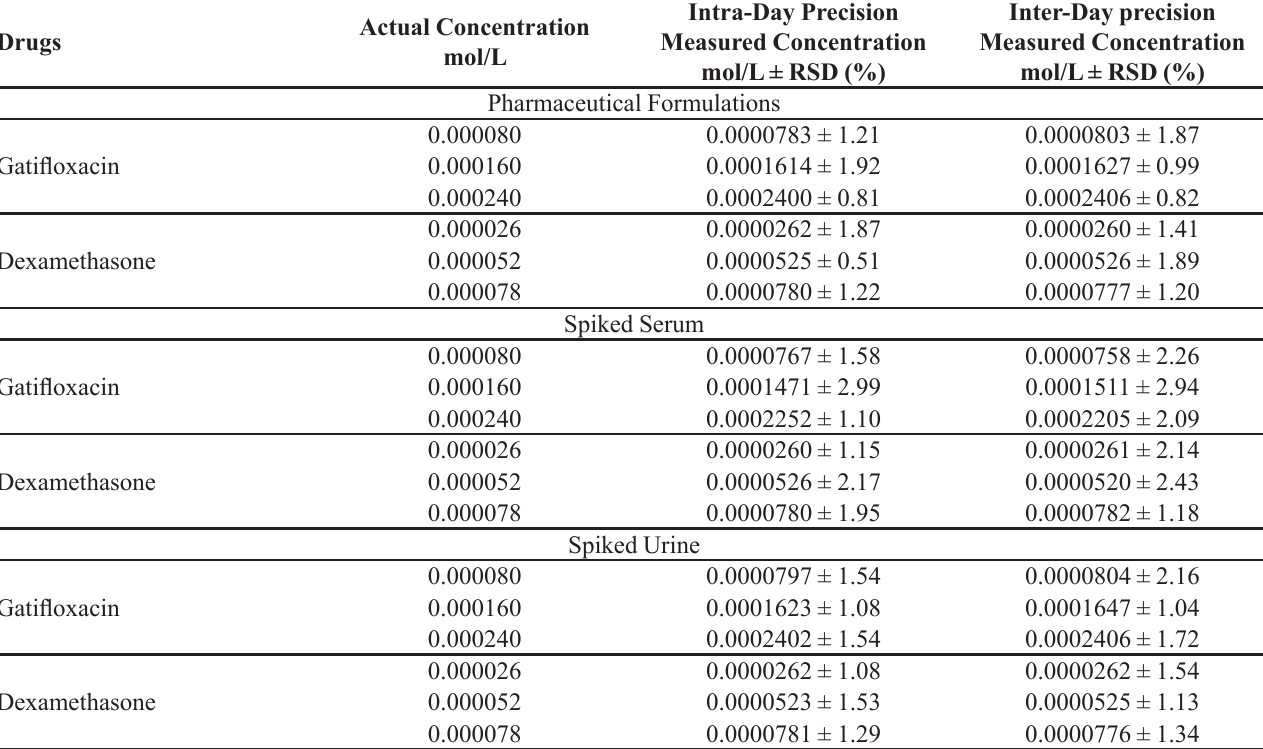
TABLE II - Intra-Day and Inter-Day precision of the proposed HPLC method